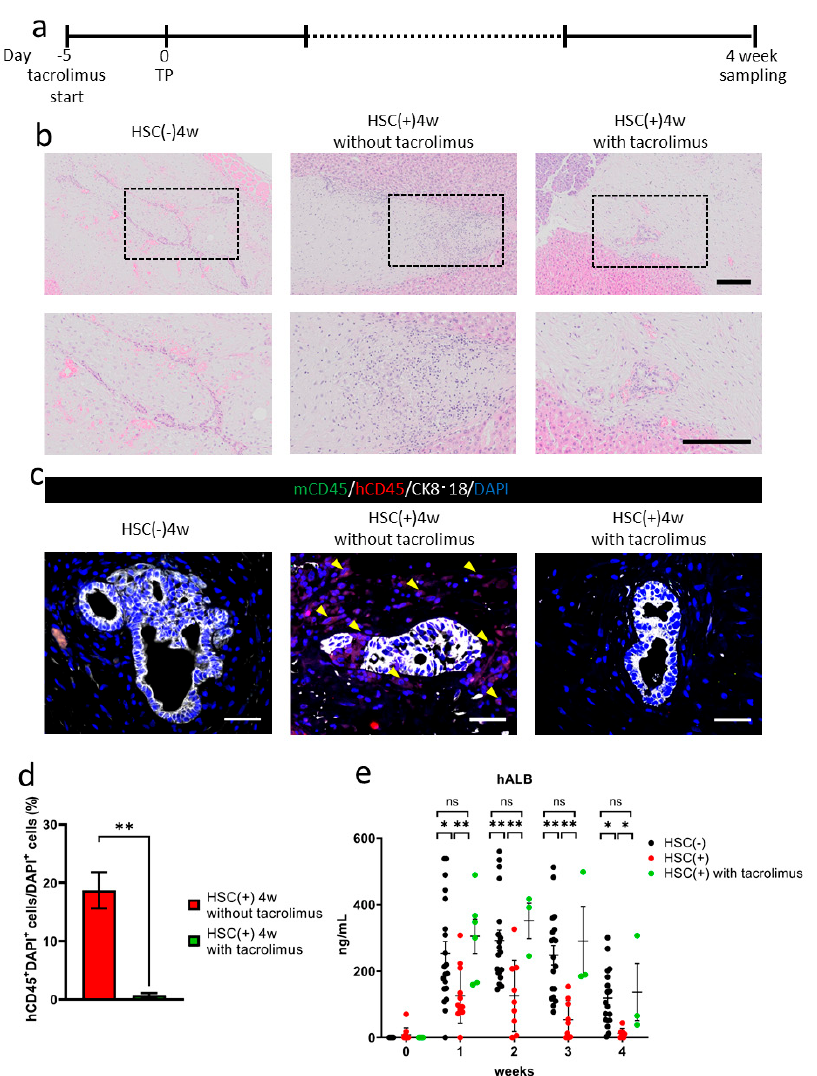
Figure 4. Tacrolimus administration to NOG-HLA-A2Tg. ( a ) The tacrolimus administrating schedule is shown. ( b ) Hema- toxylin and eosin staining. Top row shows low magnification, and bottom row shows a zoomed-in image of the black frame border. Scale bar: 200 µ m. ( c , d ) Immunohistochemistry. ( c ) Human lymphocyte detection: mCD45 (green), hCD45 (red), CK8 · 18 (white), and DAPI (blue). Arrowheads show hCD45 + cells. Scale bar: 50 µ m. ( d ) Count of the hCD45 + cells ratio. Error bar: SEM, Mann–Whitney U test. * p < 0.05, HSC(+) 4w in the absence of tacrolimus, n = 12 and HSC(+) 4 weeks with tacrolimus, n = 17. ( e ) Human albumin (hALB) concentration in mouse blood. Two-way repeated measures ANOVA with Tukey’s multiple comparisons test, ns: no significant difference, * p < 0.05 and ** p < 0.001, HSC( − ), n = 18–20, HSC( + ), n = 7–12, and HSC(+) with tacrolimus, n =